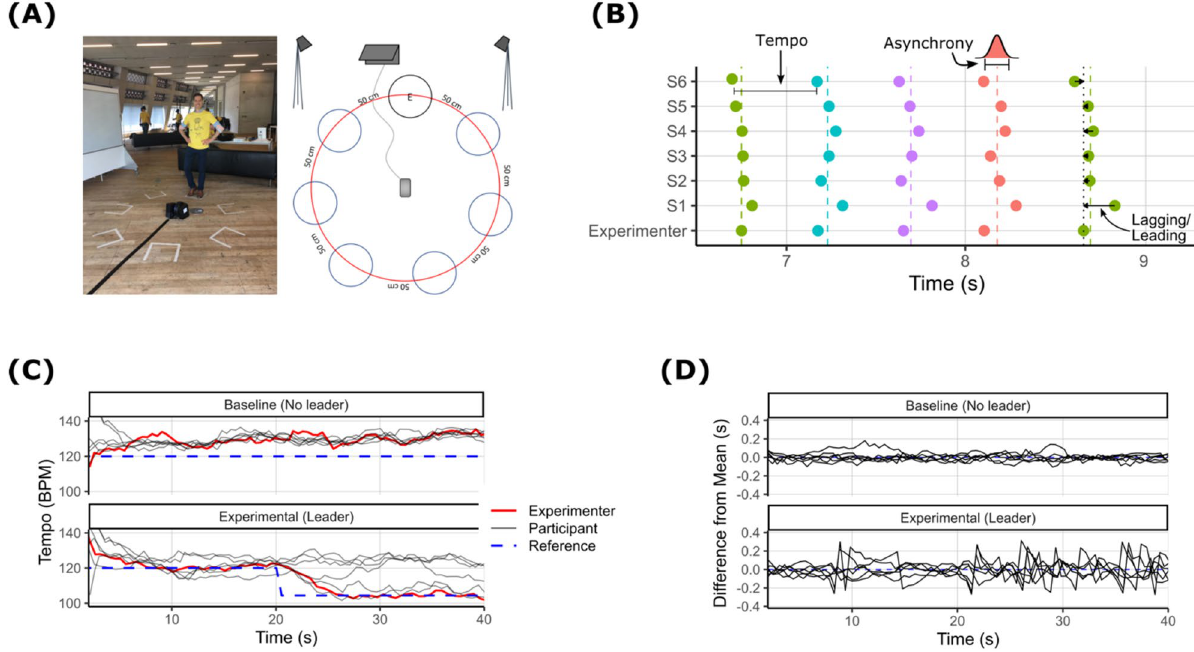
Figure 1. Study design and sample data illustrating dynamic changes in coordination. The R software 78 package tidyverse version 1.3.0 79 (https:// doi. org/ 10. 21105/ joss. 01686) was used to plot these figures. ( A ) A novel, and ecological group walking paradigm, where six participants and an experimenter, marked as “E”, formed a circle facing each other around a set of speakers. From the speakers, six initiation beats were heard, after which participants were instructed to continue walking on the spot at the given tempo. ( B ) Clustered step times for each participant and the experimenter over a short segment of a single trial. Dots show the times of individual footsteps. Colour-coding indicates step cluster labels. Coloured dash lines show mean step times. Participant tempo (60/ISI, where ISI is the inter-step interval) is used for calculating coordination with target tempo, asynchrony (standard deviation each group member’s step times) is used for calculating coordination with the group members, and lagging/leading behind/ahead of the experimenter is used for calculating our exploratory measure of coordination with the experimenter. ( C ) Coordination with target tempo for a single group over time. After 20 s in the experimental trial, the experimenter increases their tempo to 104 BPM. For illustration, tempo is calculated in a four-step rolling window for each participant. ( D ) Coordination with the group for the same participants over time. Group coordination is measured as the standard deviation of the six participants’ step times in each step cluster. When group coordination is low (baseline trial), each participant’s step times are close to the mean. When coordination is high (experimental trial), step times are widely spread around the